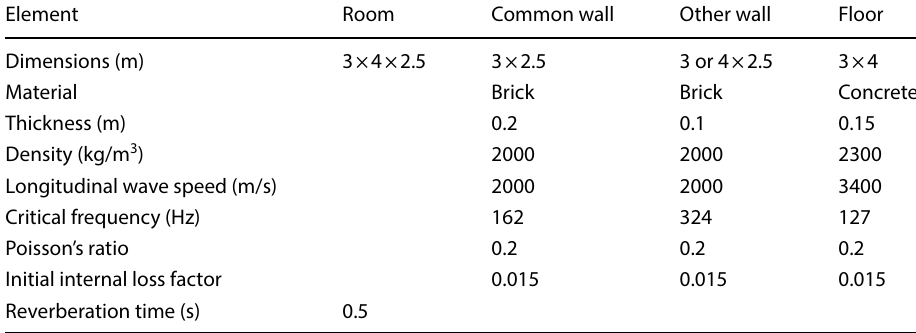
Table 1 Dimensions and material properties of the systems in Fig. 19